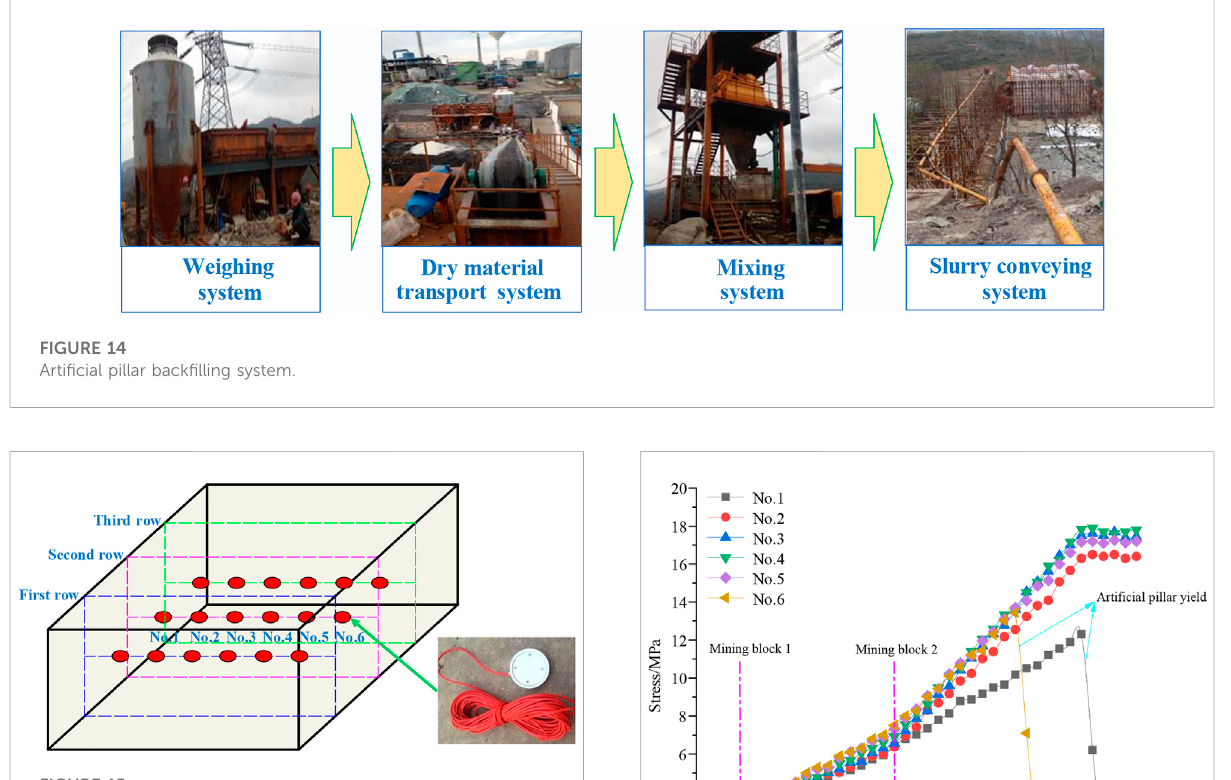
FIGURE 15 Earth pressure cells layout.